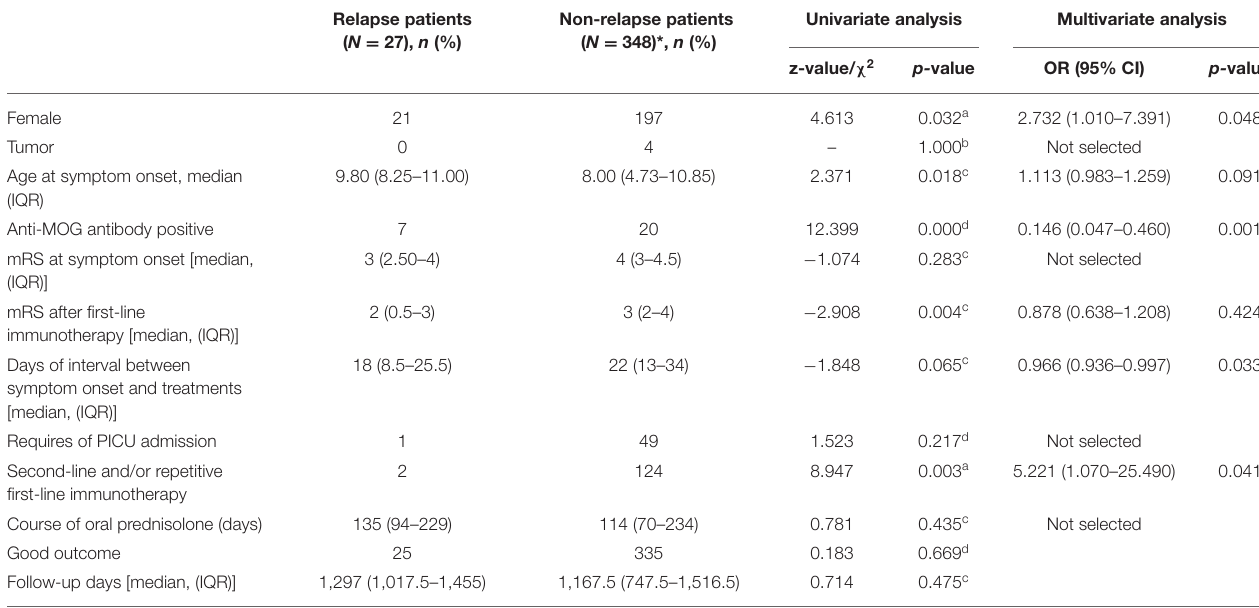
TABLE 6 | Comparison of clinical characteristics of relapsed and non-relapsed patients.